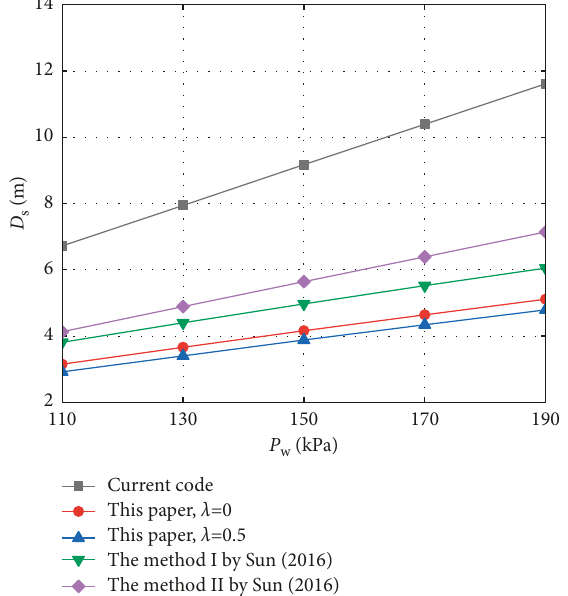
Figure 6: Critical safety thickness of the base corresponding to B × L � 10 m × 20m.